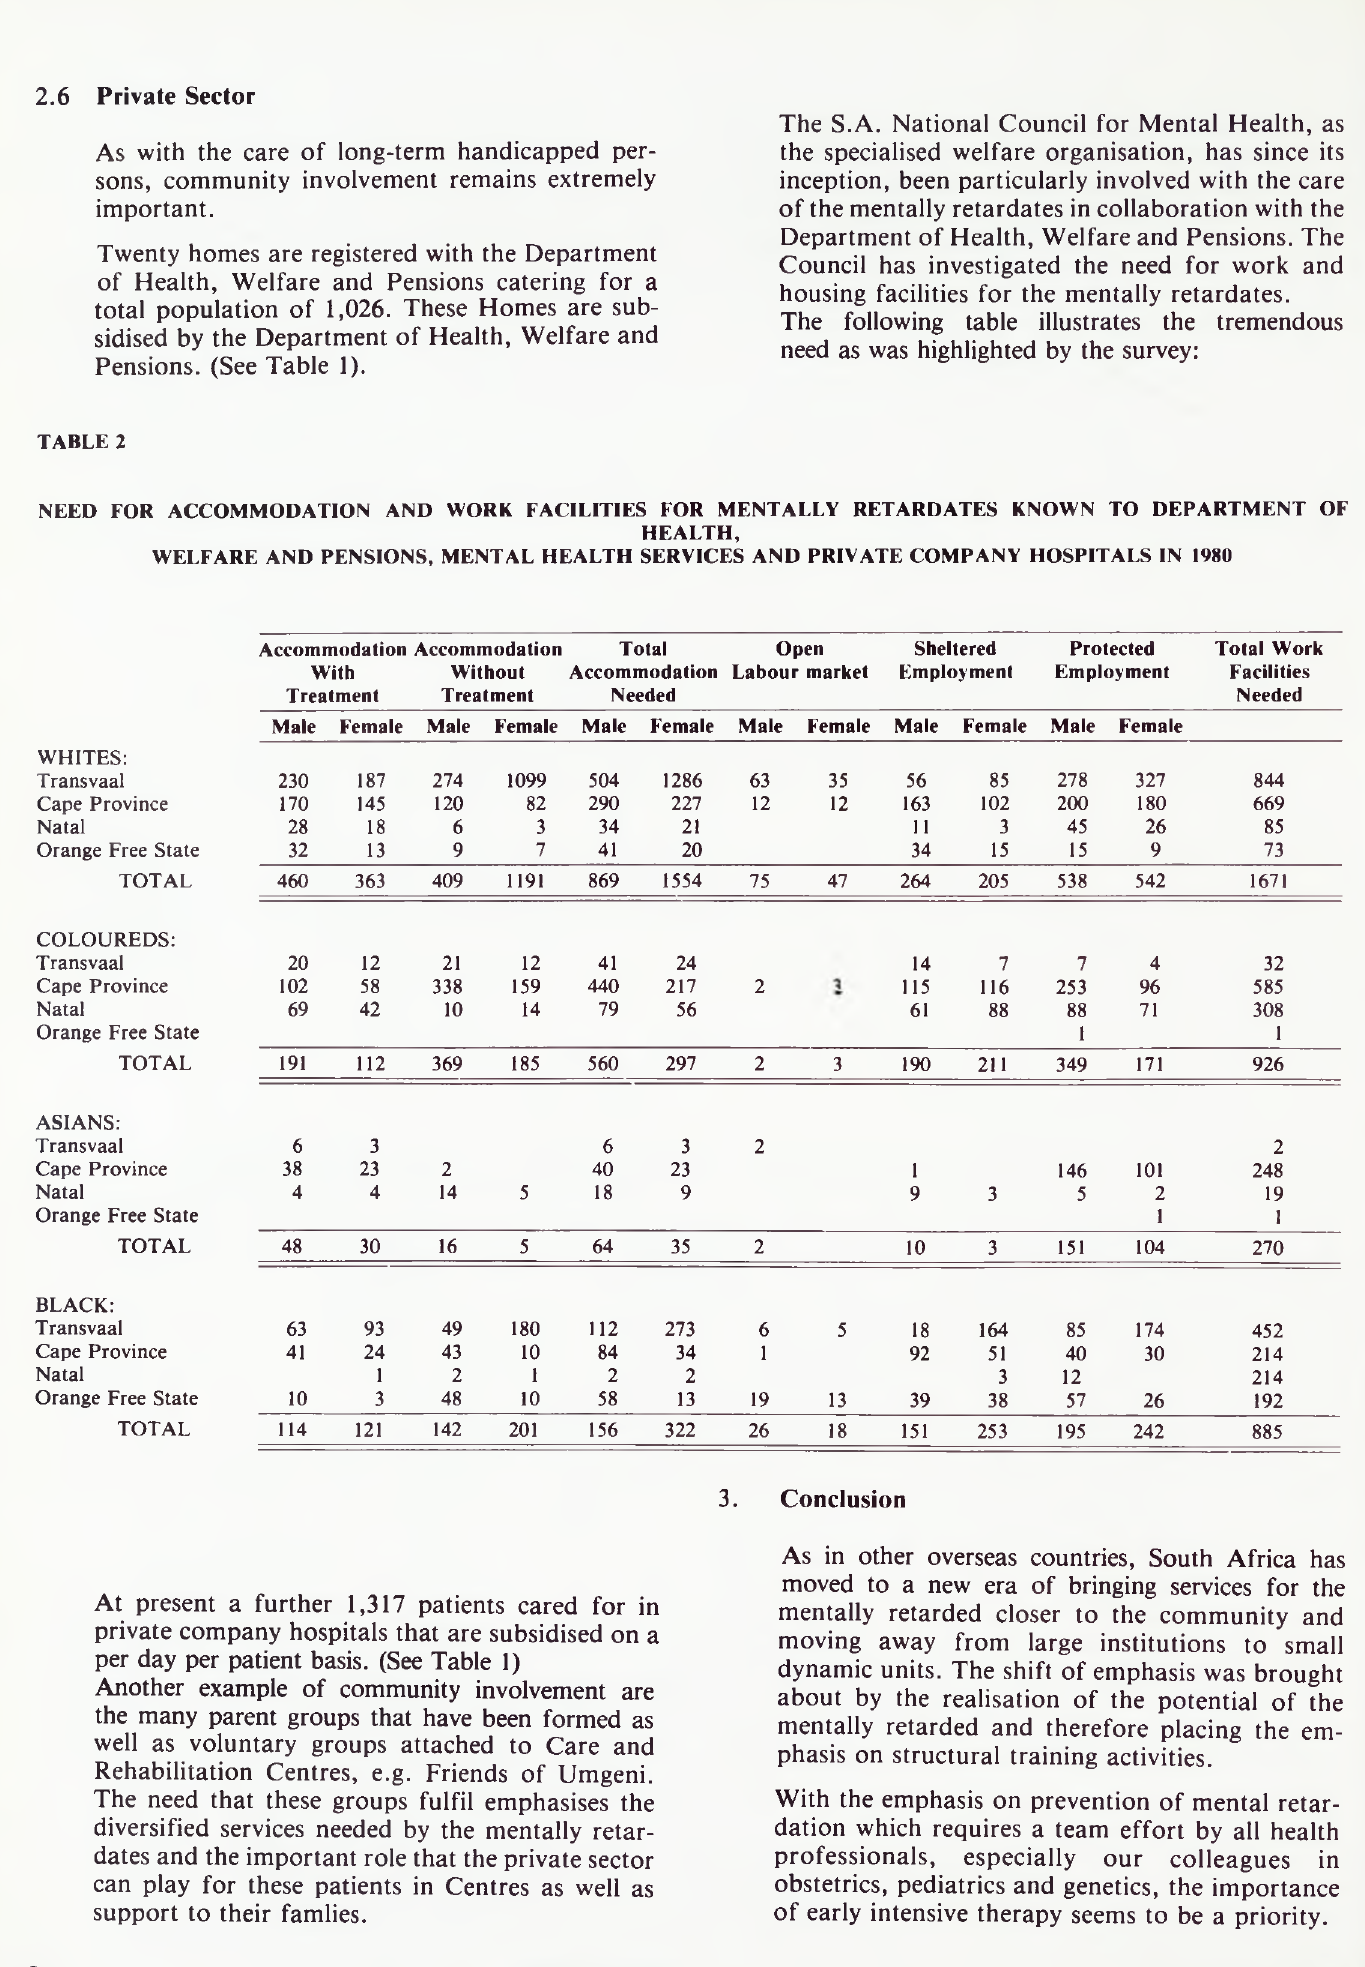
NEED FOR ACCOMMODATION AND WORK FACILITIES FOR MENTALLY RETARDATES KNOWN TO DEPARTMENT OF HEALTH, WELFARE AND PENSIONS, MENTAL HEALTH SERVICES AND PRIVATE COMPANY HOSPITALS IN 1980